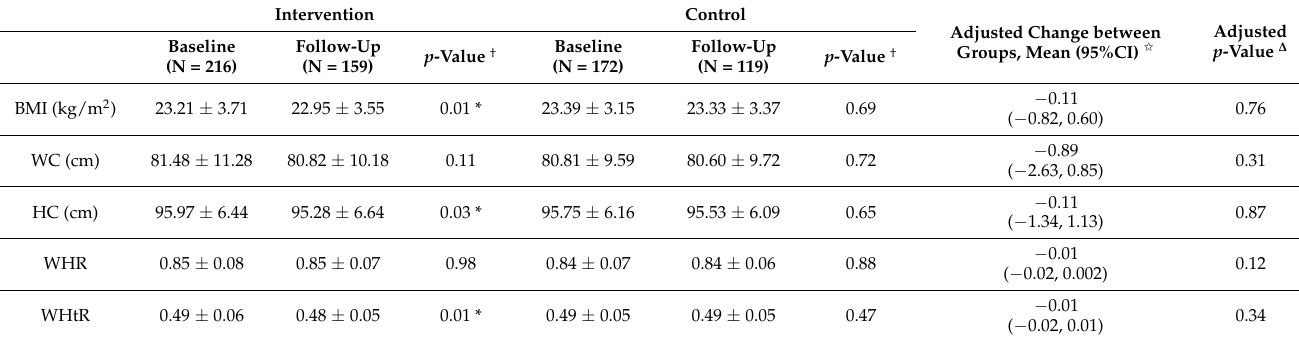
Table 2. Comparison of weight-related indicators between the intervention and control worksites from baseline to